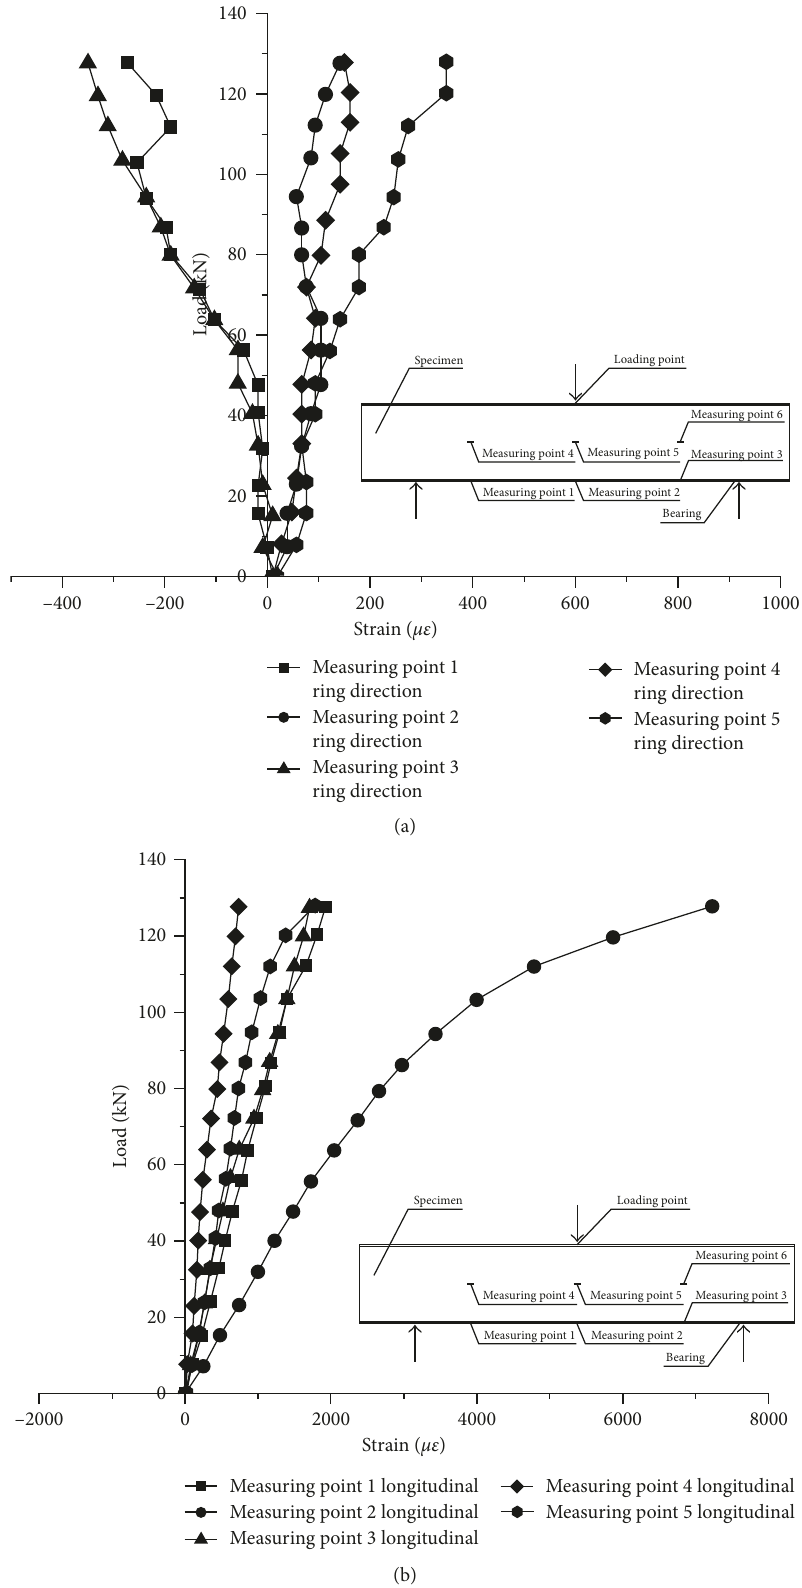
Figure 10: (a, b) Strain-load curves for each measuring point of specimen